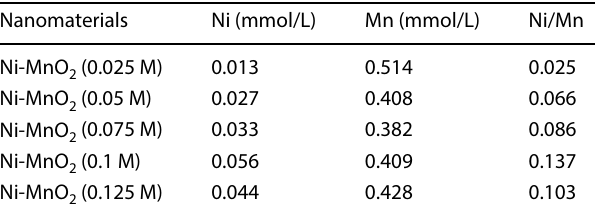
nanoparticles analysis results through ICP- 2